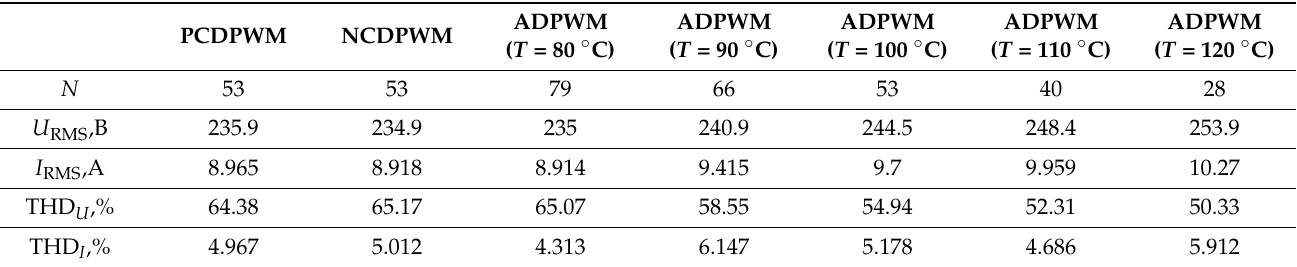
Table 6. Simulation results at MI = 0.9.